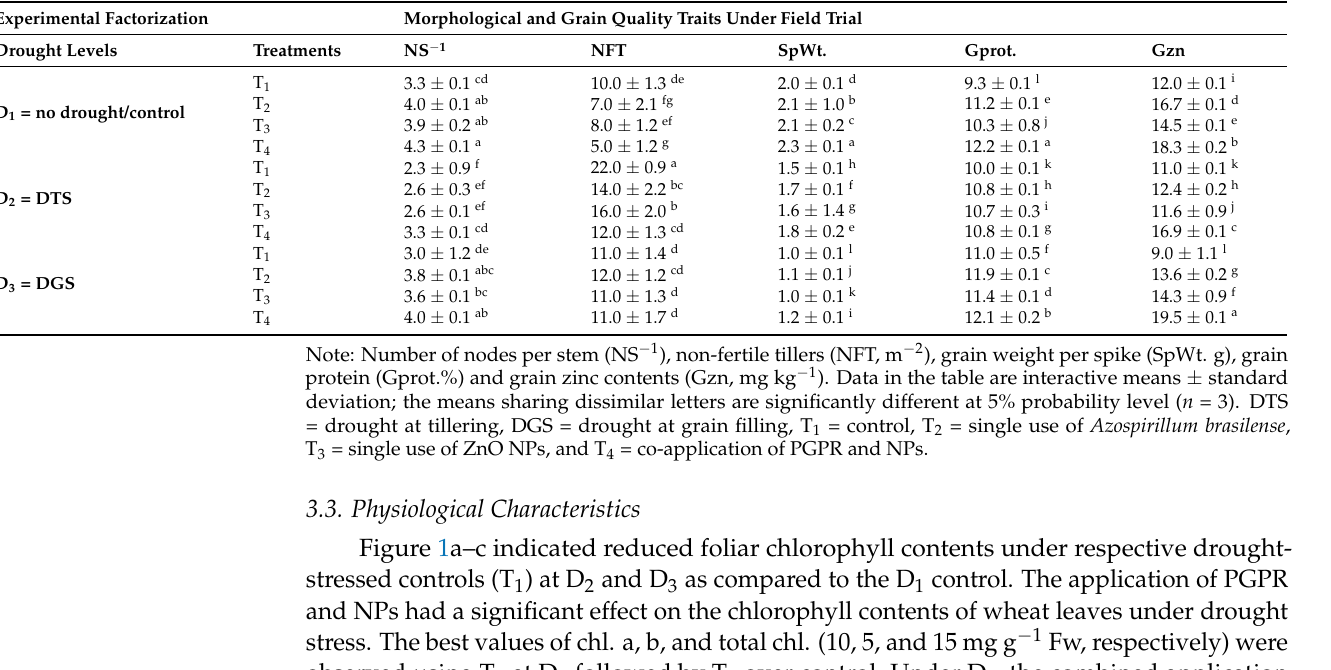
Table 3. Responses of wheat to sole or co-application of Azospirillum brasilense and Zinc oxide nanoparticles (ZnO NPs) during drought.